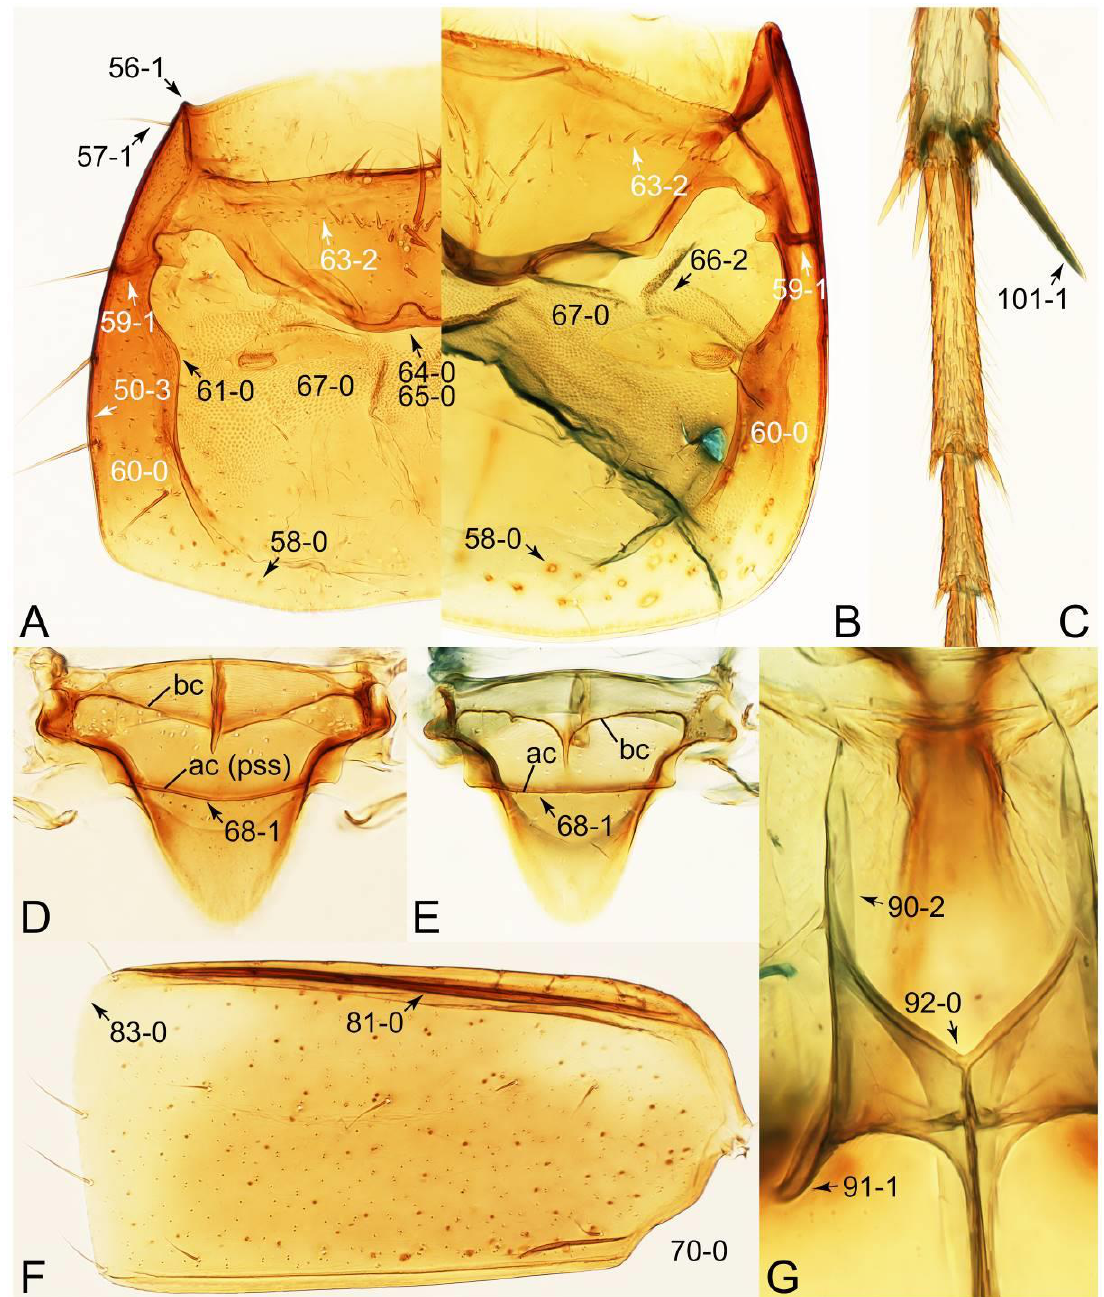
Figure 69. Photographs of body parts of Mycetoporinae, enlarged. ( A ) prosternum and pronotum of Bryoporus cf. orientalis , ventral view. ( B ) prosternum and pronotum of Carphacis effrenatus , ventral view. ( C ) left metatarsus and metatibial spines of Carphacis effrenatus , dorsal view. ( D ) scutellum of Bolitobius castaneus , dorsal view. ( E ) scutellum of Carphacis effrenatus , dorsal view. ( F ) left elytron of Ischnosoma splendidum , dorsal view. ( G ) metendosternite of Carphacis effrenatus , dorsal view. Abbreviations: ac, apical carina; bc, basal carina; pss, prescutoscutellar suture. Characters and character states (format X-X) are indicated on each